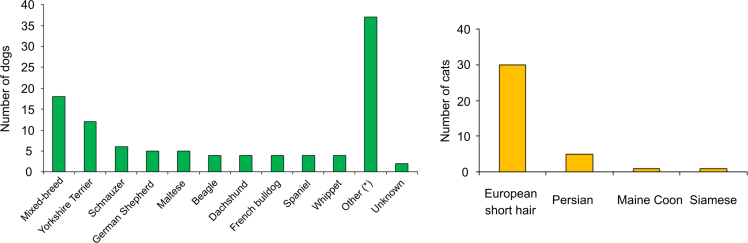
Bar plots showing the breed distribution of recruited dogs (n=105, left panel) and cats (n=37, right panel). *Other dog breeds (n): Boxer (3), Setter (3), Shih Tzu (3), American Staffordshire Terrier (2), Belgian Shepherd (2), Border Collie (2), Chinese Shar-Pei (2), Cocker Spaniel (2), Golden Retriever (2), Labrador Retriever (2), Pug (2), Shiba Inu (2), Andalusian Hound (1), Chihuahua (1), Dalmatian (1), Galician Palleiro (1), Hound (1), Mastiff (1), Miniature Pinscher (1), Pit bull (1), Poodle (1), Water dog (1).